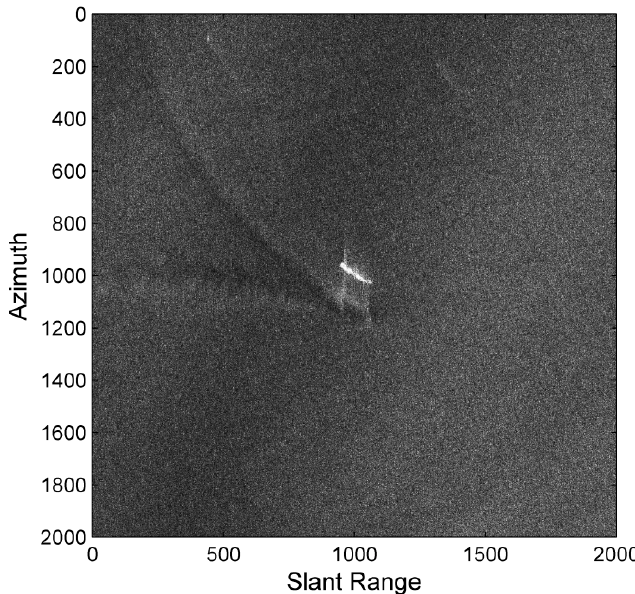
Figure 4. Different wake structure example.